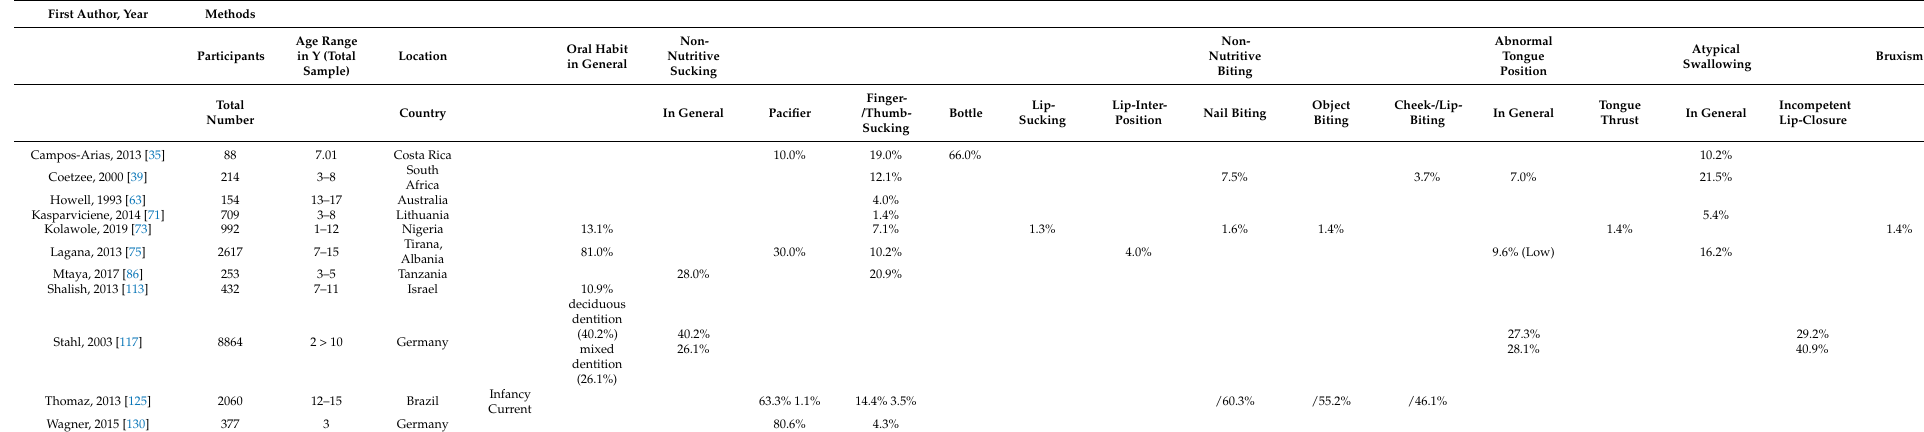
Table 3. Prevalence of oral